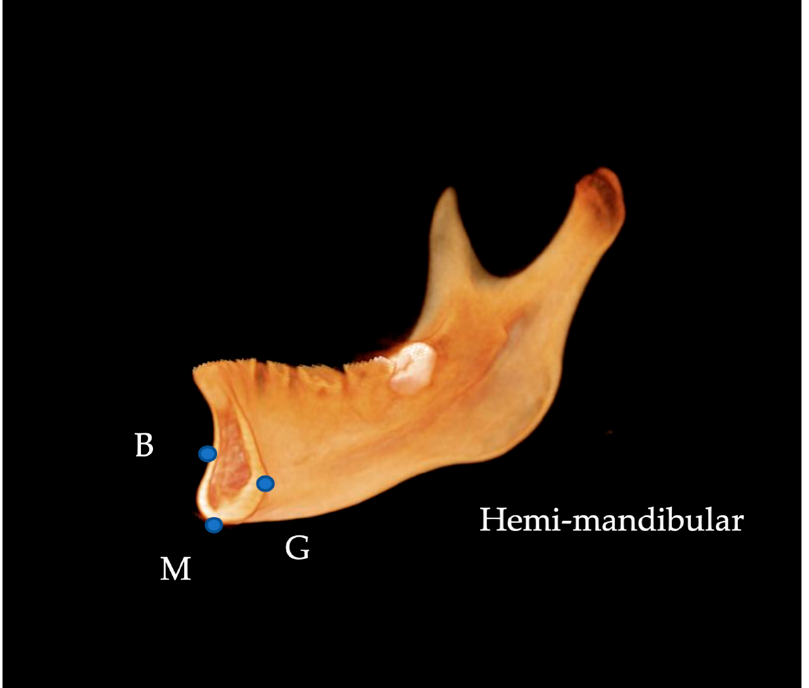
Figure 2. Segmentation of the mandible. M, menton; G, genial tubercle; B, supramentale.